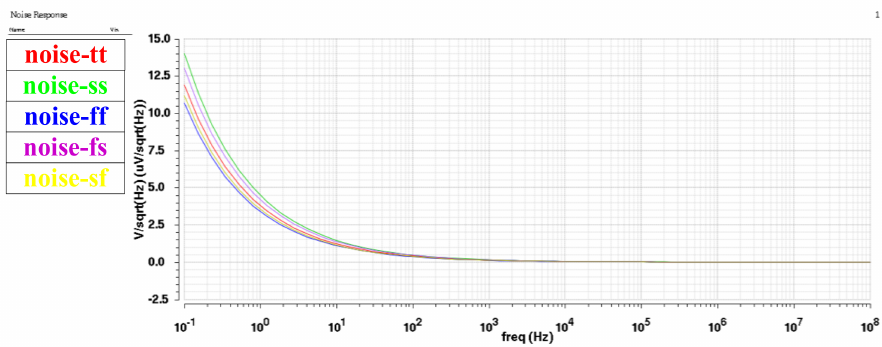
Figure 16. The simulated noise power-density spectrum of the proposed circuit under 5 different process corners.